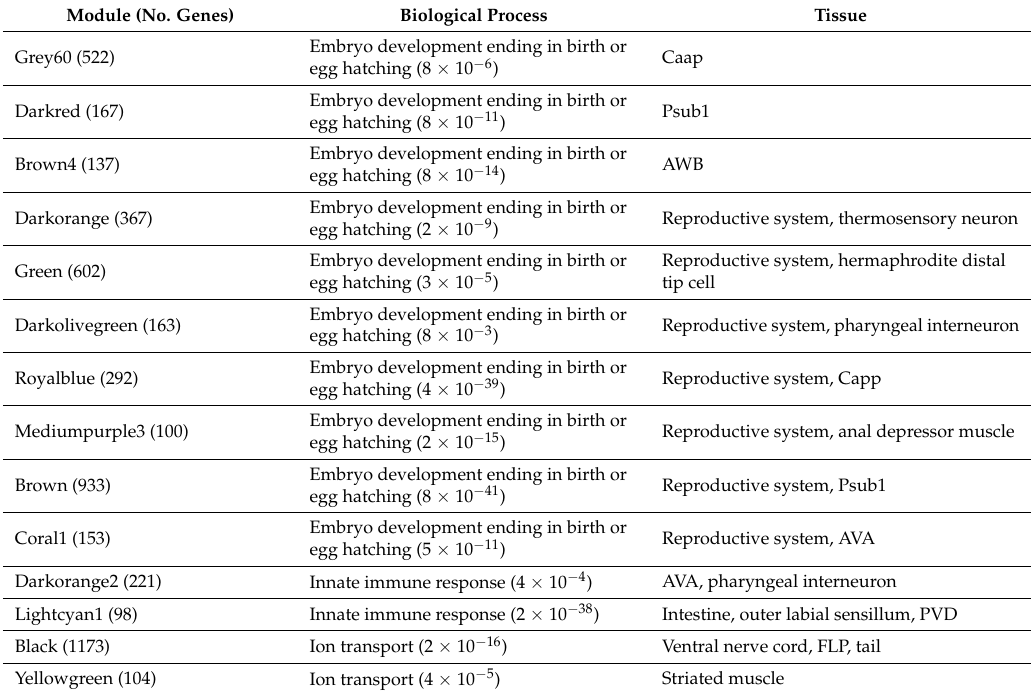
Table 2. Tissue enrichment for the 22 gene co ‐ expression modules with the same GO BP annotation in C. elegans .